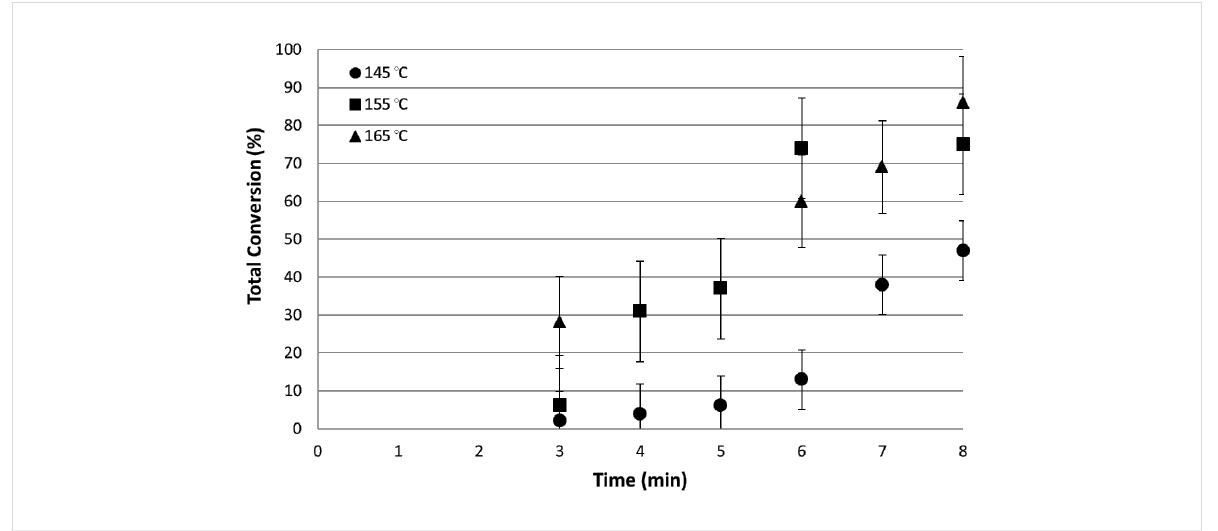
Figure 3: Total conversion of 4-iodoanisole as a function of reactor run time for three reaction temperatures.